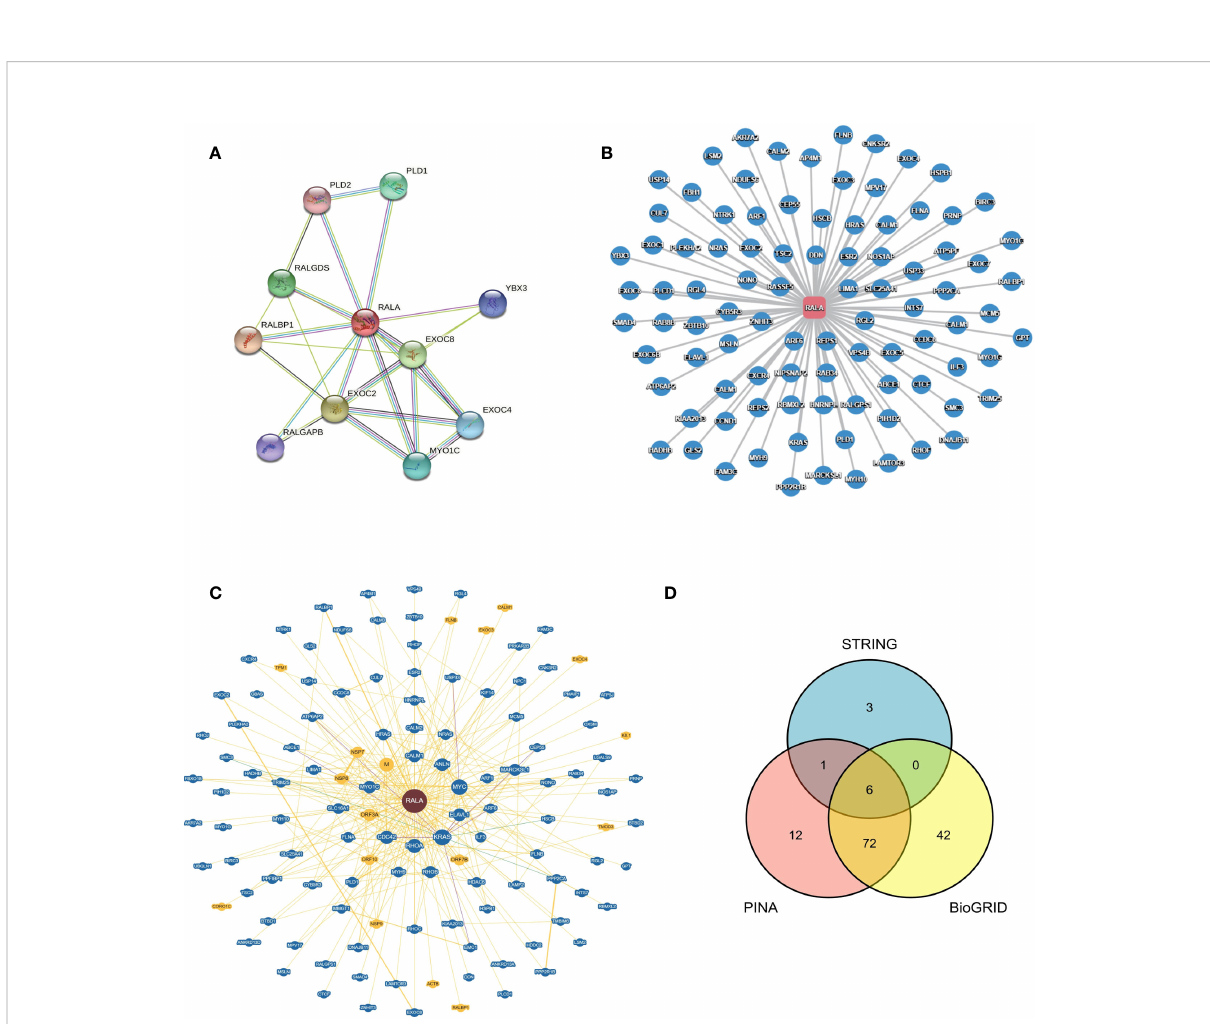
FIGURE 6 Protein - protein Interaction network of RALA in different databases. (A) STRING, (B) PINA, (C) BioGRID, (D) Venn diagram of genes interacting with RALA in three different